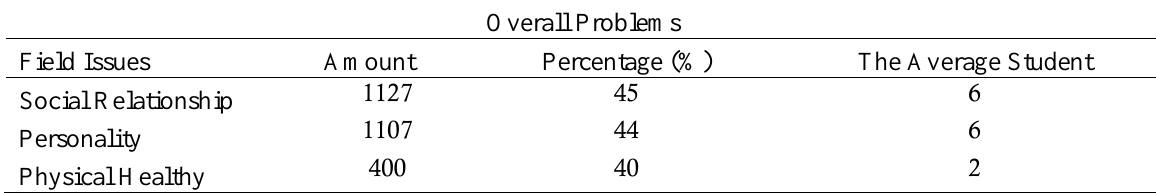
Table 2. The highest problem of junior high school